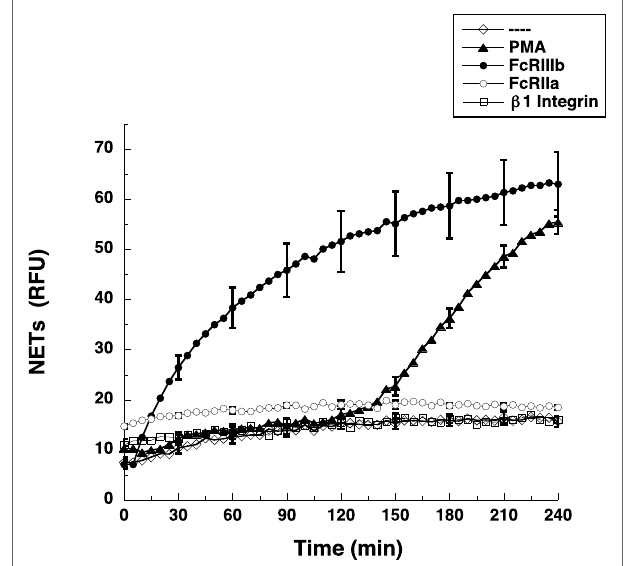
FigUre 1 | Fc γ riiib induces neT formation faster than PMa . Human neutrophils were left untreated (---), or were stimulated with 20 nM phorbol 12-myristate 13-acetate (PMA), or by cross-linking Fc γ RIIIb with mAb 3G8, or by cross-linking Fc γ RIIa with mAb IV.3, or by cross-linking β 1 integrins with mAb TS2/16, and then incubated for 4 h. The relative amount of NETs was estimated from SYTOX ® Green fluorescence in relative fluorescent units (RFU) every 5 min. Data are mean ± SEM of three experiments done in